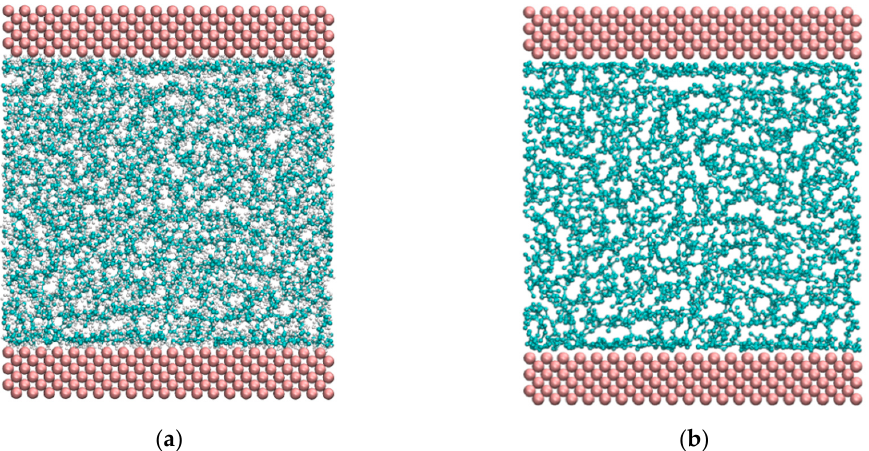
Figure 9. Snapshots at the end of the simulation ( h 0 = 6 nm, P = 1291 MPa): ( a ) snapshot of all atoms; ( b ) snapshot of iron atoms and carbon–carbon bonds remained.